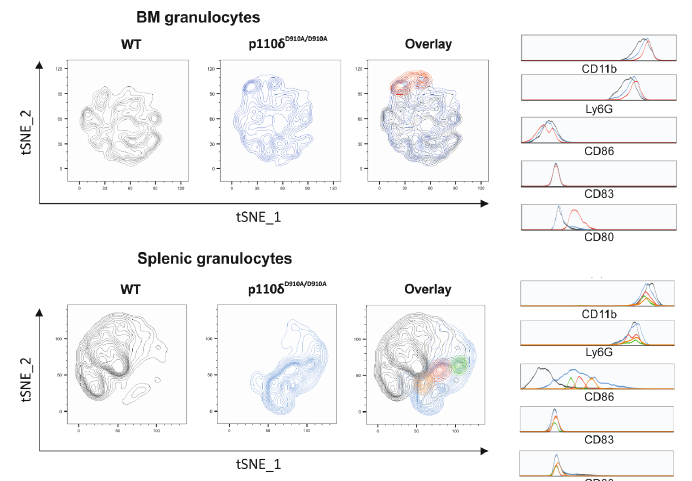
Figure 5. tSNE analysis of the phenotype of granulocytes isolated from WT (grey) and p110δ D910A/D910A (blue) mice. ( above ) Analysis of granulocytes isolated from bone marrow (BM). The overlay of counterplots presents the BM granulocyte subpopulation, specific for p110δ D910A/D910A mice (red). ( below ) Analysis of granulocytes isolated from the spleen. The overlay of counterplots presents three distinct subpopulations, specific for p110δ D910A/D910A mice (red, orange and green). The granulocytes were plotted on the graphs according to the expressions of CD83, CD86 and